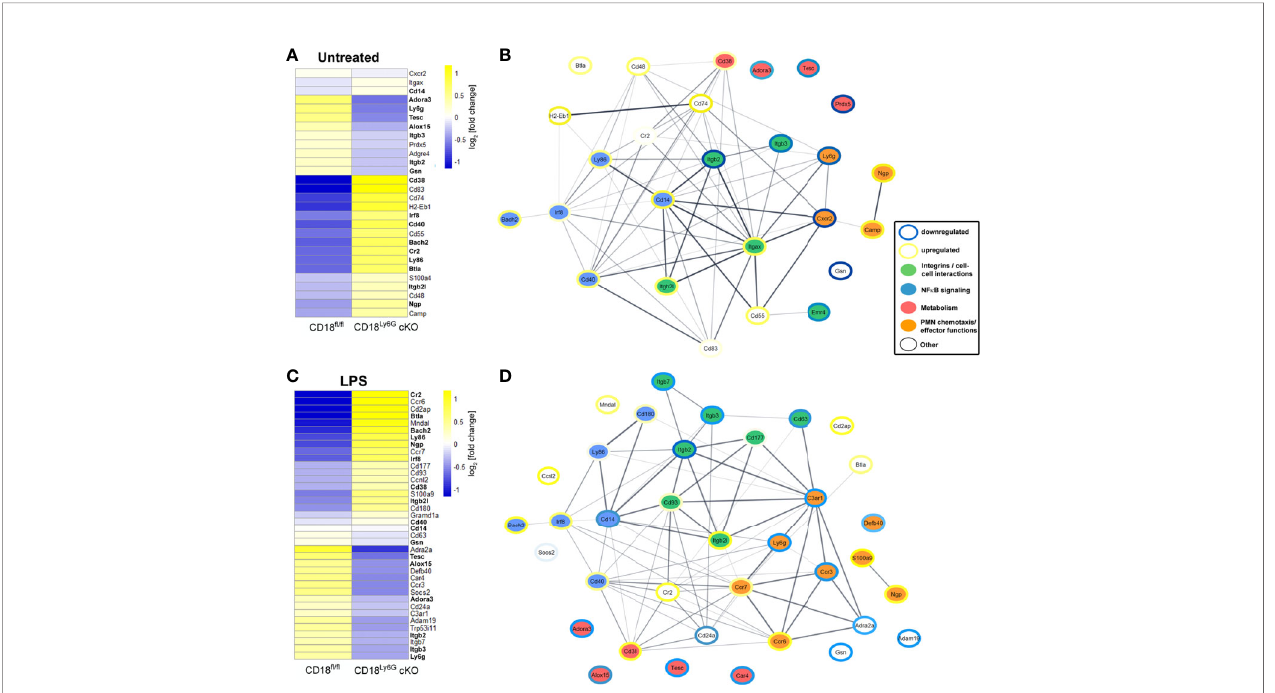
FIGURE 9 | Transcriptomes and functional interaction networks of PMN-associated genes directly after isolation or upon over-night treatment with LPS. PMN were sorted from CD18 fl / fl and CD18 Ly6G cKO mice (each n=3) and RNA-seq was performed from untreated PMN (A) or LPS-treated PMN (C) . Expression of indicated PMN-associated genes was analyzed using CLC Genomics Workbench. Genes being differentially regulated both in LPS-treated and freshly isolated PMN are shown in bold (A, C) . Predicted interaction networks of the encoded proteins were being visualized using the STRING package in Cytoscape. Genes shown in the interaction networks of untreated PMN (B) or LPS-treated PMN (D) were categorized into 4 groups affecting either PMN cell-cell interactions, NF k B singaling, PMN metabolism or PMN chemotaxis and PMN effector functions. Colored borders illustrate the degree of the up- or downregulation (log fold change) found for the genes of PMN isolated from CD18 Ly6G cKO mice as compared to PMN isolated from CD18 fl / fl mice. Legend in (B, D)